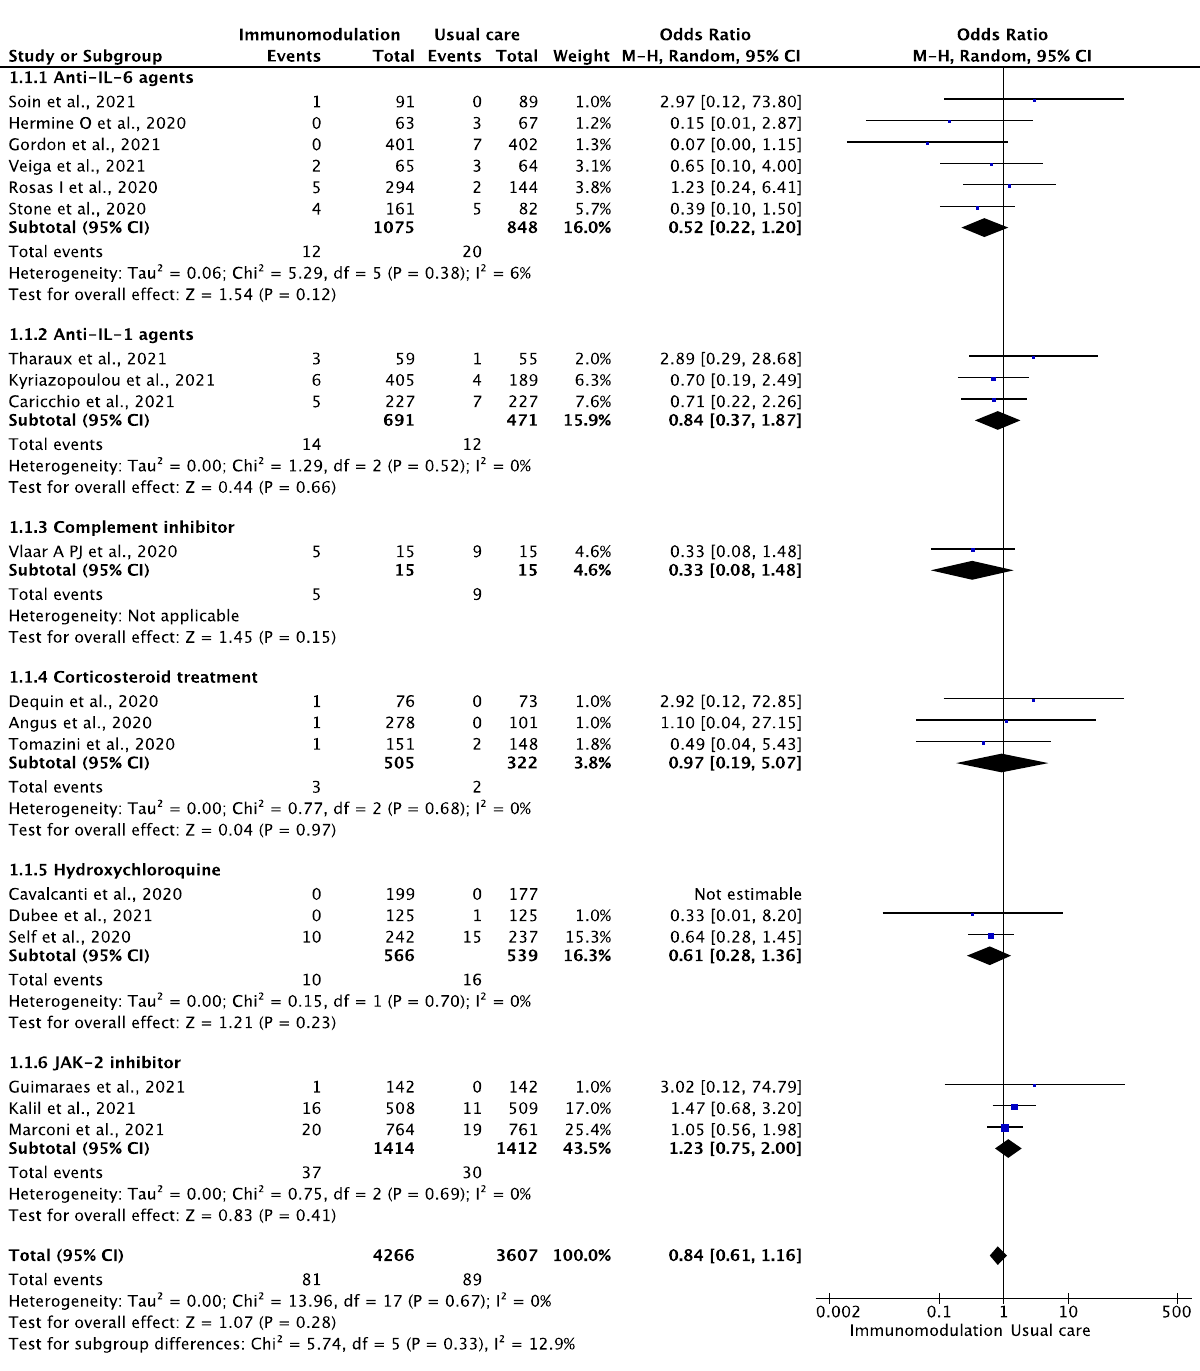
Figure 1. Odds ratio (OR) and 95% confidence intervals for the occurrence of venous thromboembolic events among the hospitalized COVID-19 patients prescribed immunomodulatory agents as an add-on to usual care vs. usual care only. Boxes represent the OR and lines represent the 95% CIs for individual studies. The diamonds and their width represent the pooled ORs and the 95% CIs, respectively. CI, confidence interval for the Mantel–Hansen estimator, I 2 :